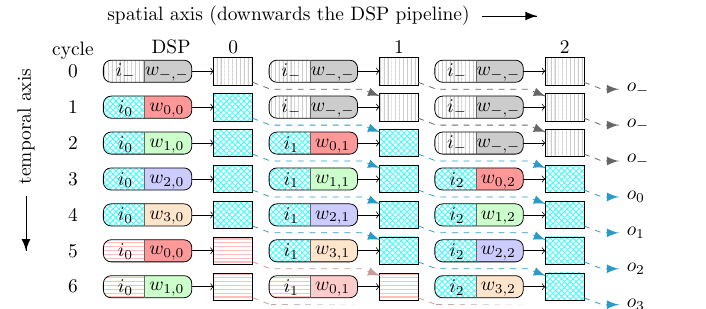
Figure 1. Schematic showing the data flow for the fully-connected layer. Gray (vertical lines) refers to no data set available / idling, while cyan (crosshatch) and pink (horizontal lines) refer to data of a first and second data set, respectively. The inputs of neighboring pipeline stages are updated in subsequent cycles and only once per data cycle, while the weight sequence for each individual DSP is repeated during each data cycle.